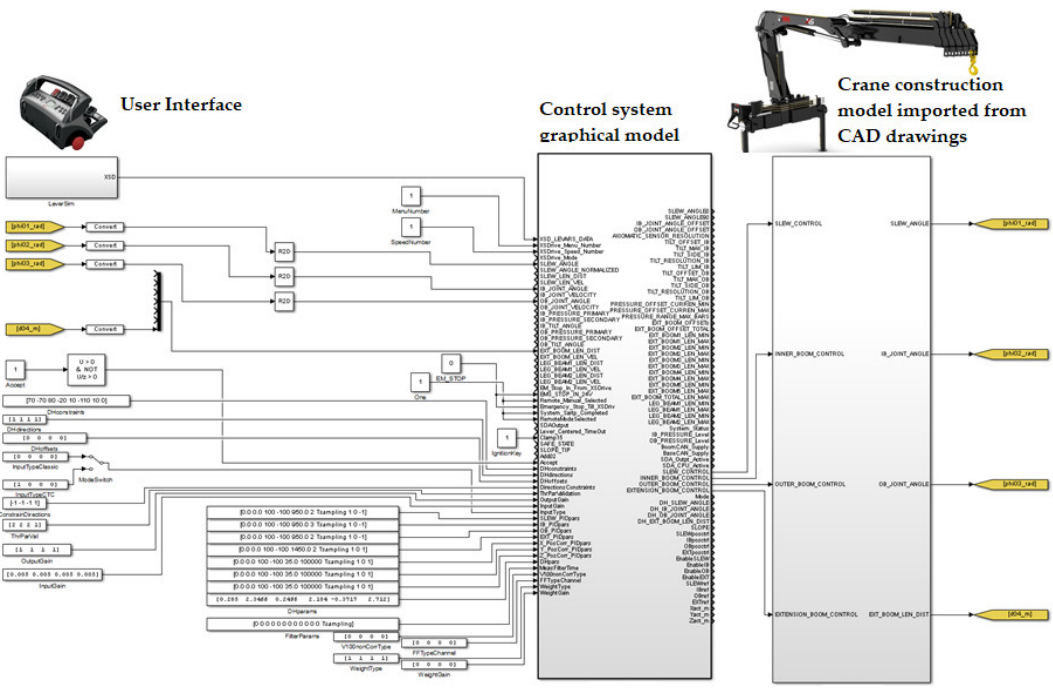
Figure 14. Virtual verification and validation of control system.